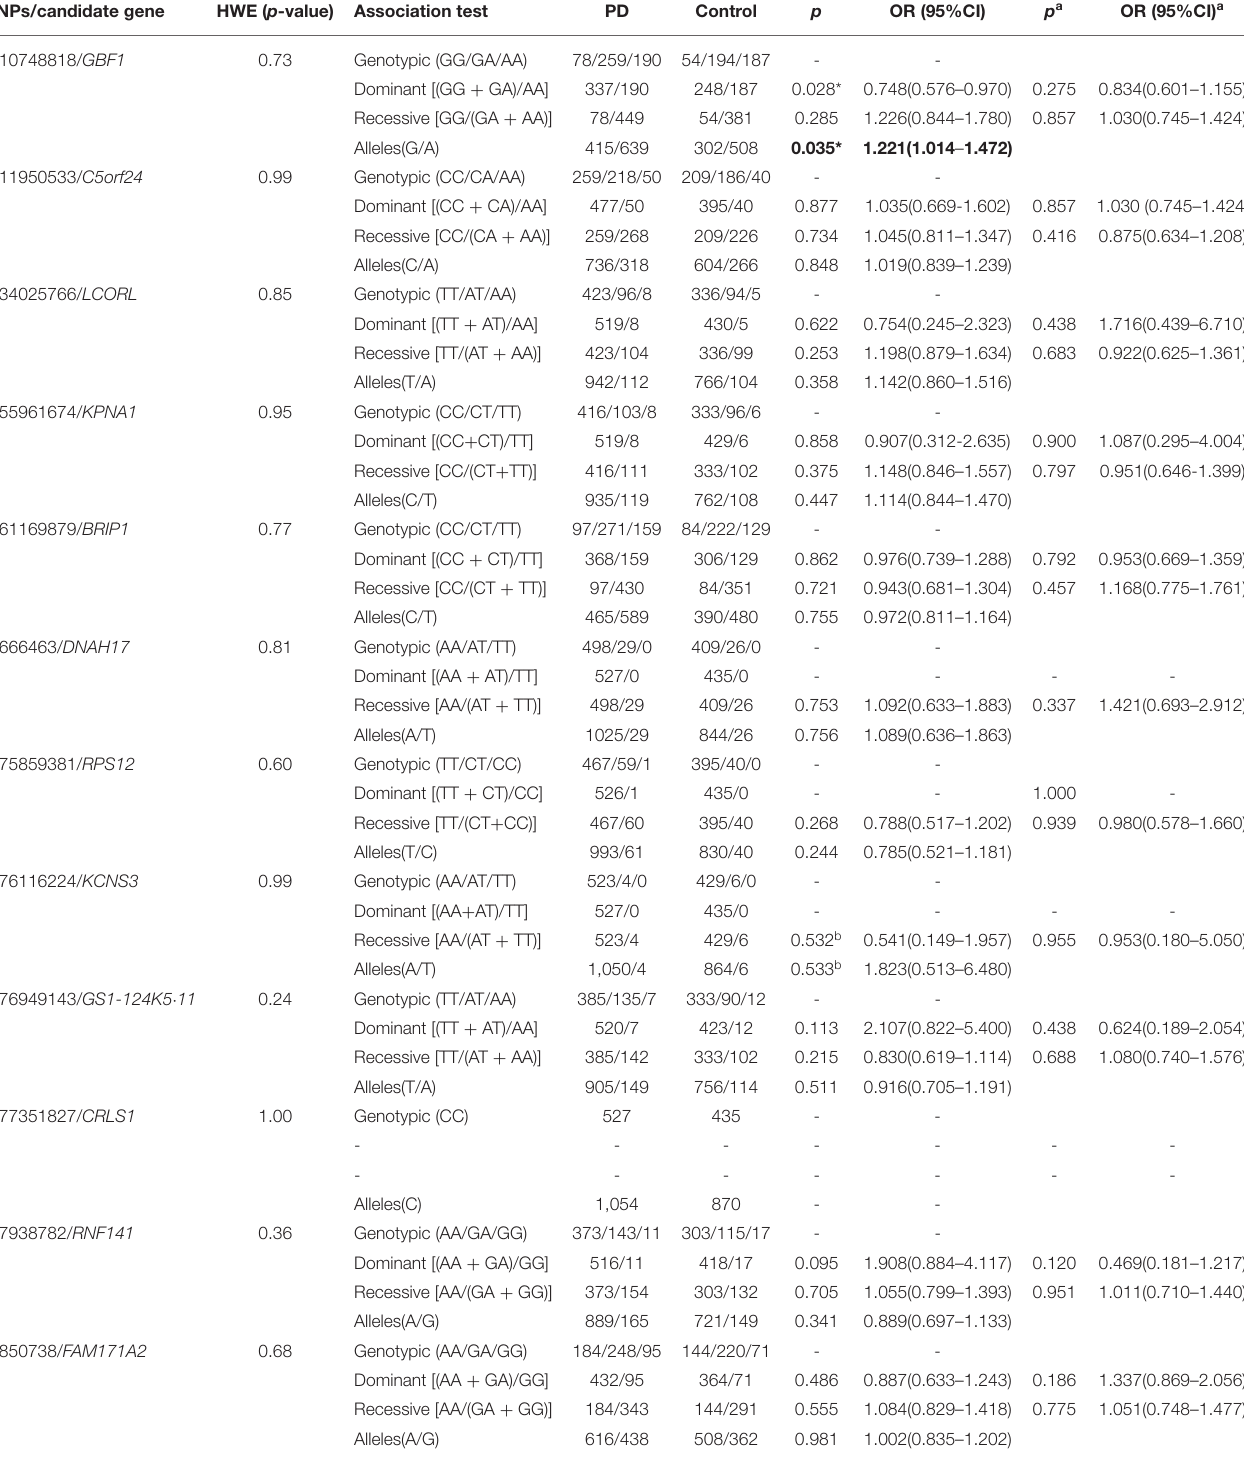
TABLE 1 | Assessment of the relationship level of 12 novel loci with PD in the Chinese Han population. SNPs/candidate